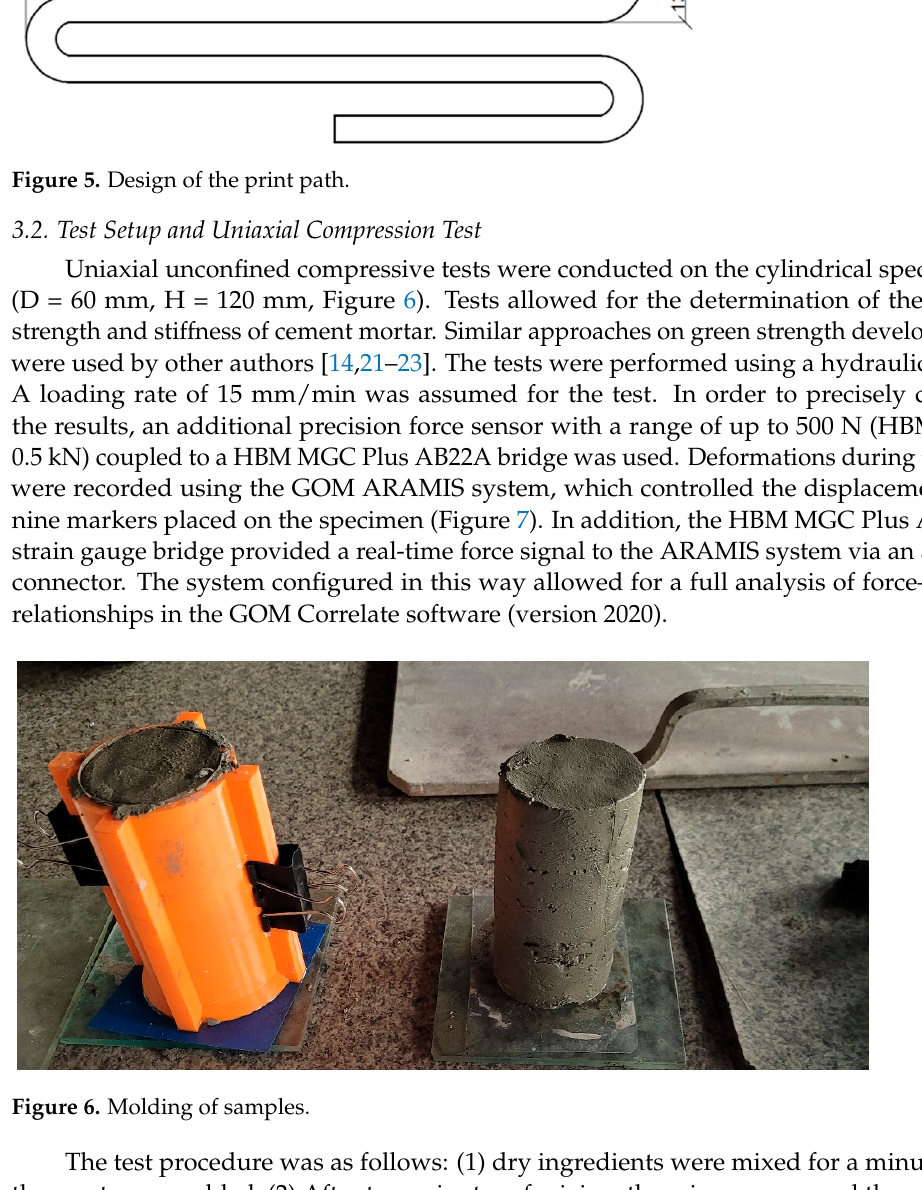
Figure 4. ( a ) Gantry robot with an extruder; ( b ) Mix pumped through the system.